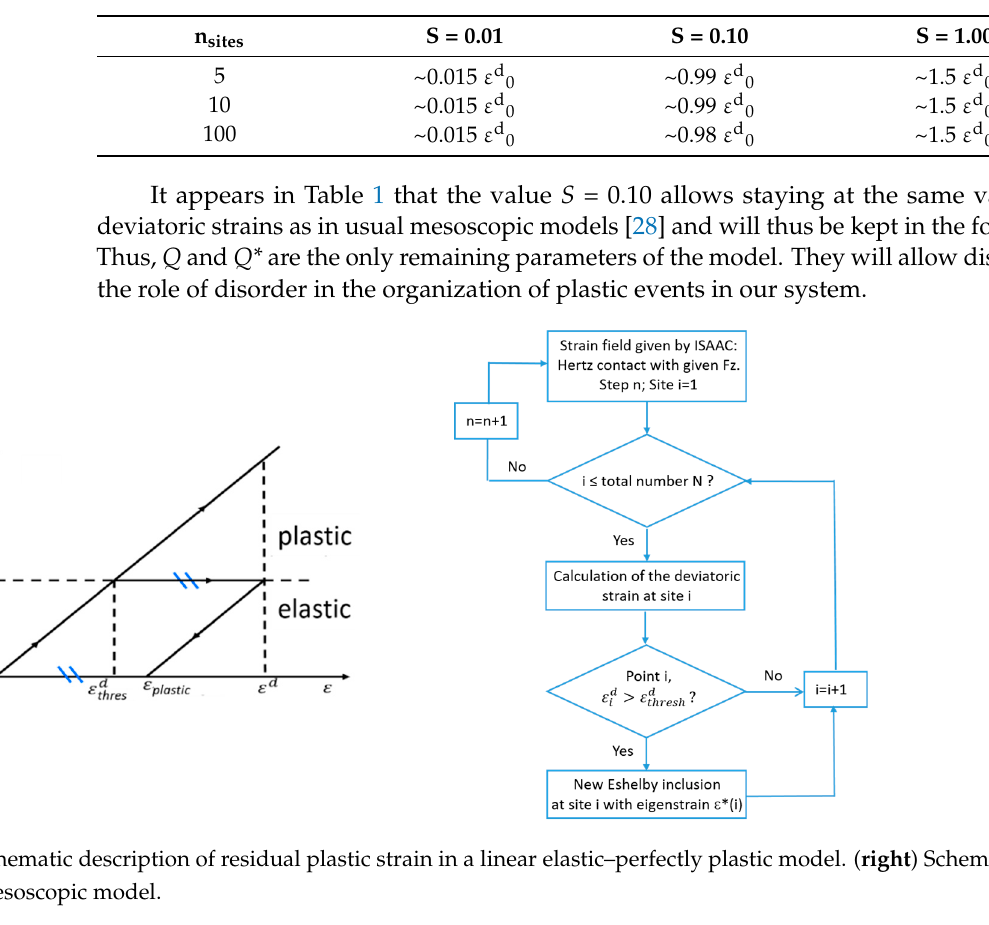
Table 1. Values of the maximum local deviatoric strain ε d1 in a contact problem without disorder after the first step, compared to the initial value of the maximum deviatoric strain ε d0 . The contact problem is described in Section 2.3, here for different values of the parameter S and different numbers n sites of simultaneously nucleated sites.